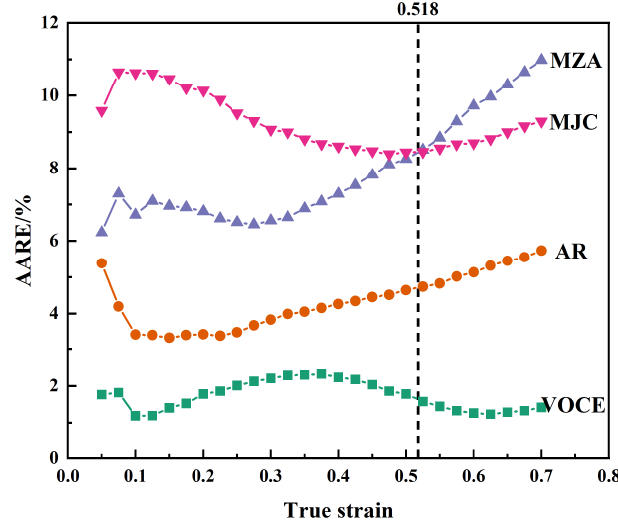
Figure 17. Schematic diagram of the effect of true strain on AARE.